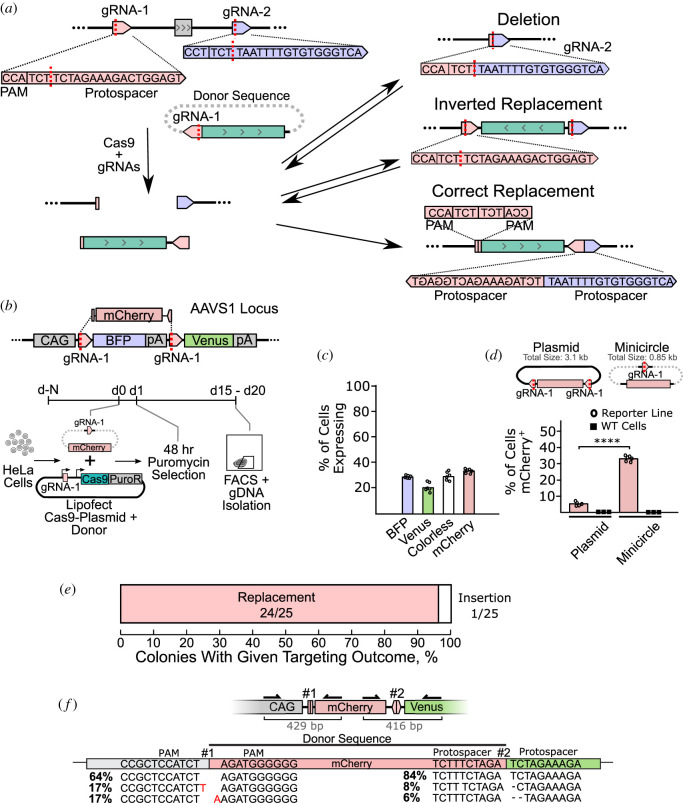
Replace targeting using HeLa reporter cells. (a) Overview of replace targeting concept: correct donor integration disrupts the Cas9 targeting sequence and is captured, while undesired products (deletion or inverted integrants) reform the gRNA target and can be further cut. (b) HeLa cells containing a fluorescent reporter system integrated into two AAVS1 loci. Targeting used gRNA-1 shown in (a) with two identical sites flanking BFP. Lipofection of Cas9-2A-puro/gRNA-1 and the donor sequence was followed by 48 h puromycin selection to ensure complete delivery. (c) Results of Replace targeting with a minicircle donor measured by FACS. BFP, original allele; Venus, deletion; mCherry, donor integration; colourless, allelic damage. Total sums to greater than 100% as cells can express two fluorophores. (d) Replace targeting using minicircles and plasmid sequence donors. WT cells are HeLa cells without the integrated reporter system. WT targeted identically. p-value was calculated using Student's t-test (****p-value <0.0001). (e) Single-cell sorted Replace targeted, mCherry+ cells were expanded and genotyped. Correct exchange of BFP by mCherry (Replacement) and mCherry integration flanking the BFP (Insertion) were both measured. (f) InDel frequencies at the interface of the integrated donor sequence in Replace targeted cells quantified by ICE deconvolution. Arrows represent primers for sequenced amplicons with sizes in grey.